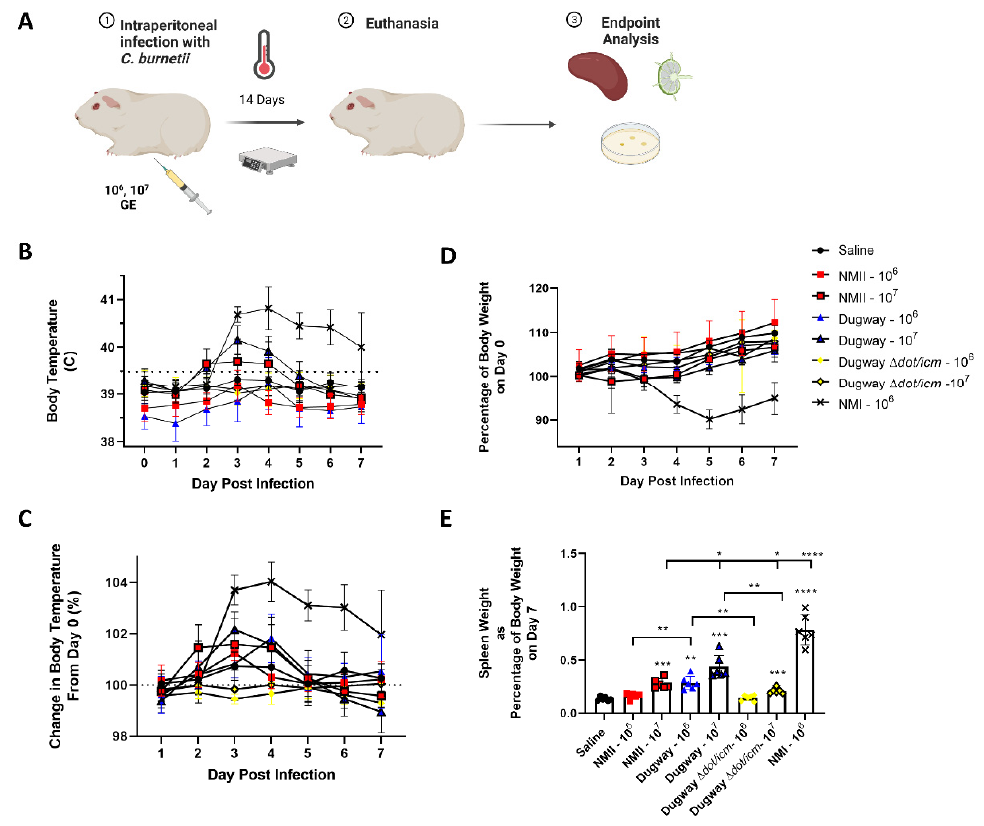
Figure 1. Coxiella burnetii Dugway strain displays reduced virulence in a robust guinea pig infection model compared to the Nine Mile strain. The guinea pig model of intraperitoneal infection is outlined in ( A ). Body temperatures ( B ), body temperature change ( C ), and body weight change ( D ) kinetics are displayed for 7 days following infection. Spleens were weighed at euthanasia (day 7) and splenomegaly was determined by normalizing spleen weight to total body weight ( E ). * p ≤ 0.05; ** p ≤ 0.01; *** p ≤ 0.001, **** p ≤